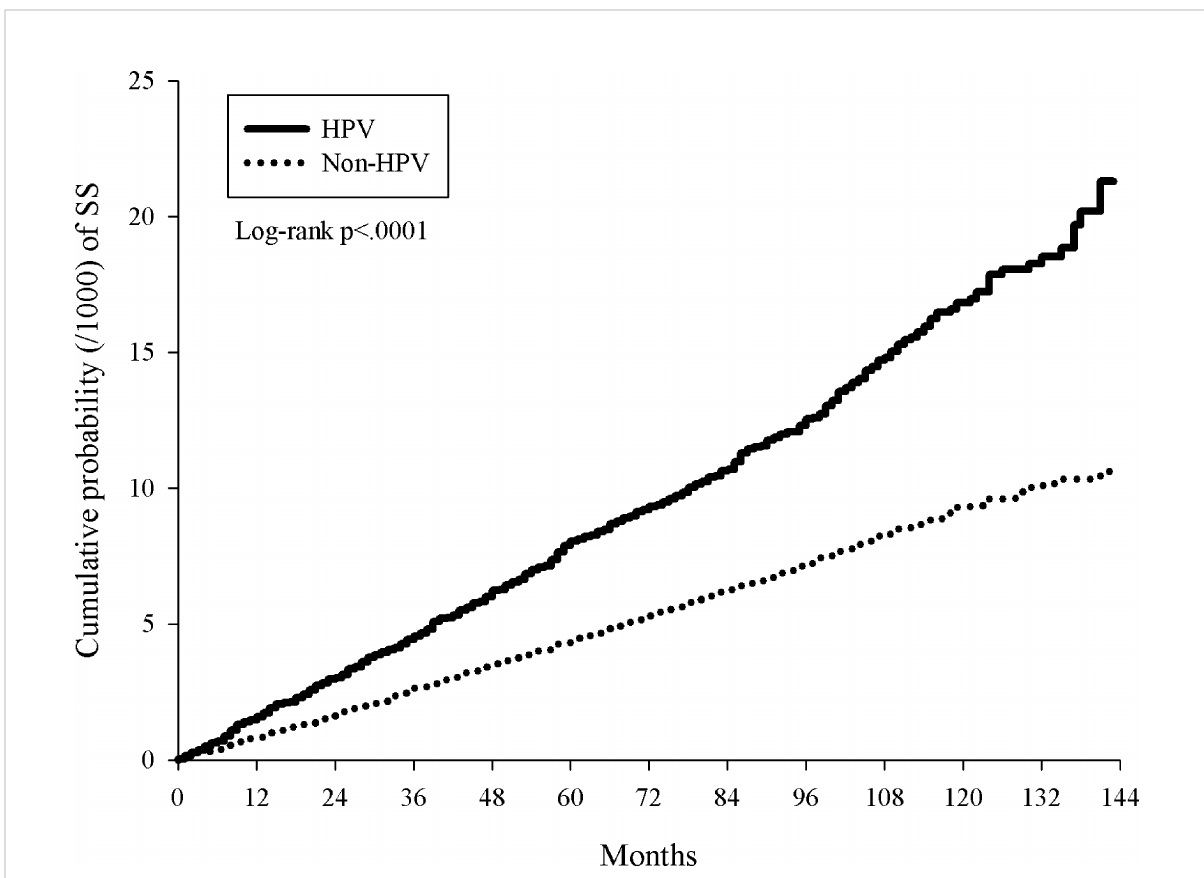
FIGURE 2 Kaplan-Meier curves of cumulative proportion of primary Sjogren ’ s syndrome in patients with HPV infections and non-HPV controls.